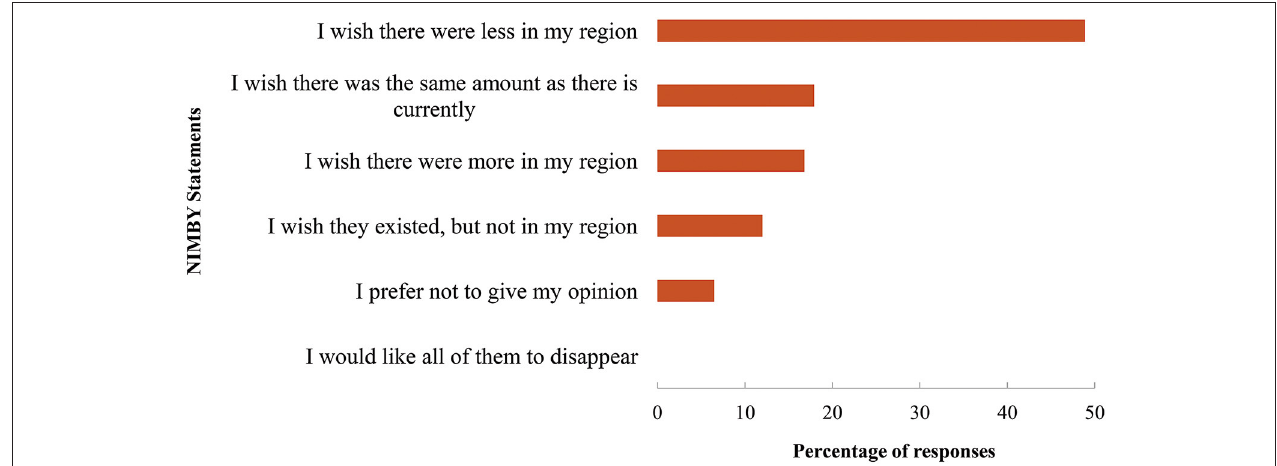
FIGURE 2 | Frequency of responses’ category to investigate the beekeepers’ NIMBY ( Not in my back yard ) sentiment about giant armadillos ( Priodontes maximus ).